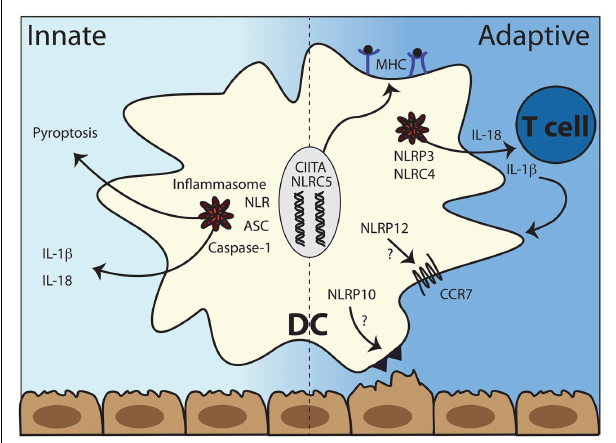
FIGURE 2 |The multiple roles of NLRs in dendritic cell function . Left panel: the recognition of intracytoplasmic triggers leads to the formation of inflammasomes and subsequent cleavage and release of the pro-inflammatory cytokines IL-1 β and IL-18 and a specific kind of cell death called pyroptosis. Right panel: antigen presentation depends critically on CIITA and NLRC5 while inflammasome activation results in IL-1 β and IL-18 production, which can have both autocrine effects on DC function as well as shape the differentiatingT cell cytokine profile. NLRP10 and NLRP12 both are involved in DC migration from peripheral tissues to draining lymph nodes although potentially via different mechanisms. DC, dendritic cells; ASC, apoptosis-associated speck-like protein containing a CARD; NLR, NOD-like receptor; CCR7, C–C chemokine receptor type 7, MHC, major histocompatibility complex (class I left and class II